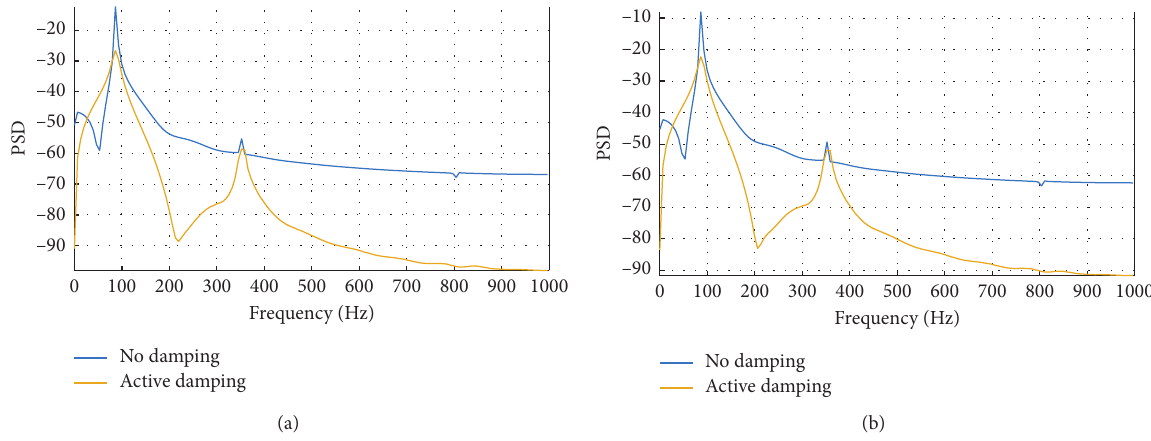
Figure 11: PSD of the first three modes of each link for the 2 nd trajectory. (a) 1 st link. (b) 2 nd link.